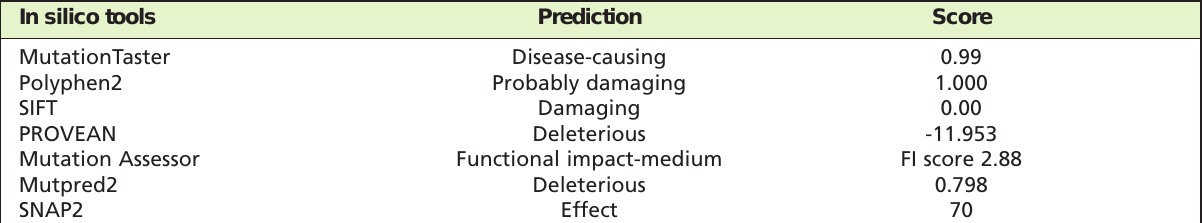
Pathogenicity prediction of the identified mutation (c.2355G>T; p. Trp785Cys) using online in silico Table I: